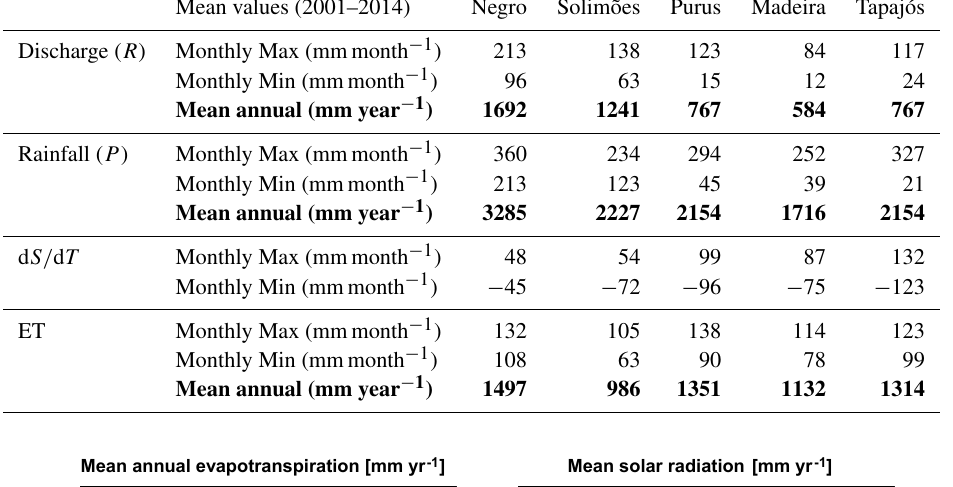
Table 1. Summary of the river discharge, rainfall, and d S/ d T in the five sub-basins analysed in this study. For each variable, the monthly average maximum and minimum, as well as the annual mean (bold values), are presented. All values are averages for the period between 2001 and 2014. Long-term annual averages of d S/ d T are generally close to zero, and therefore not presented.